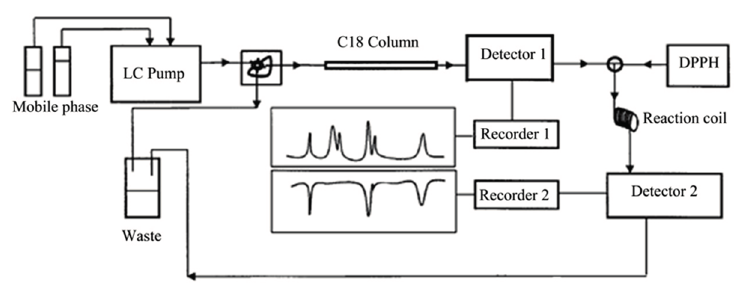
Figure 5. Instrument set-up for on-line post-column HPLC-DPPH